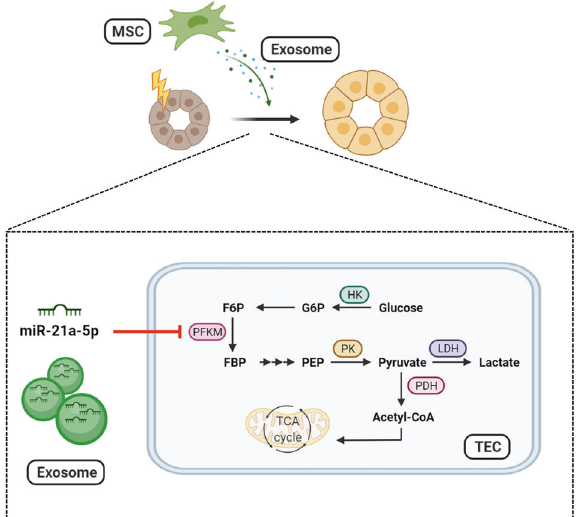
Fig. 7 Schematic diagram of the effects of MSC-Exos on glycolysis and renal fi brosis. In the process of renal fi brosis, TECs undergo a metabolic shift to aerobic glycolysis, and MSC-Exos are able to attenuate renal fi brosis by inhibiting glycolysis in TECs via the miR- 21a-5p/PFKM pathway. The schematic diagram was created by